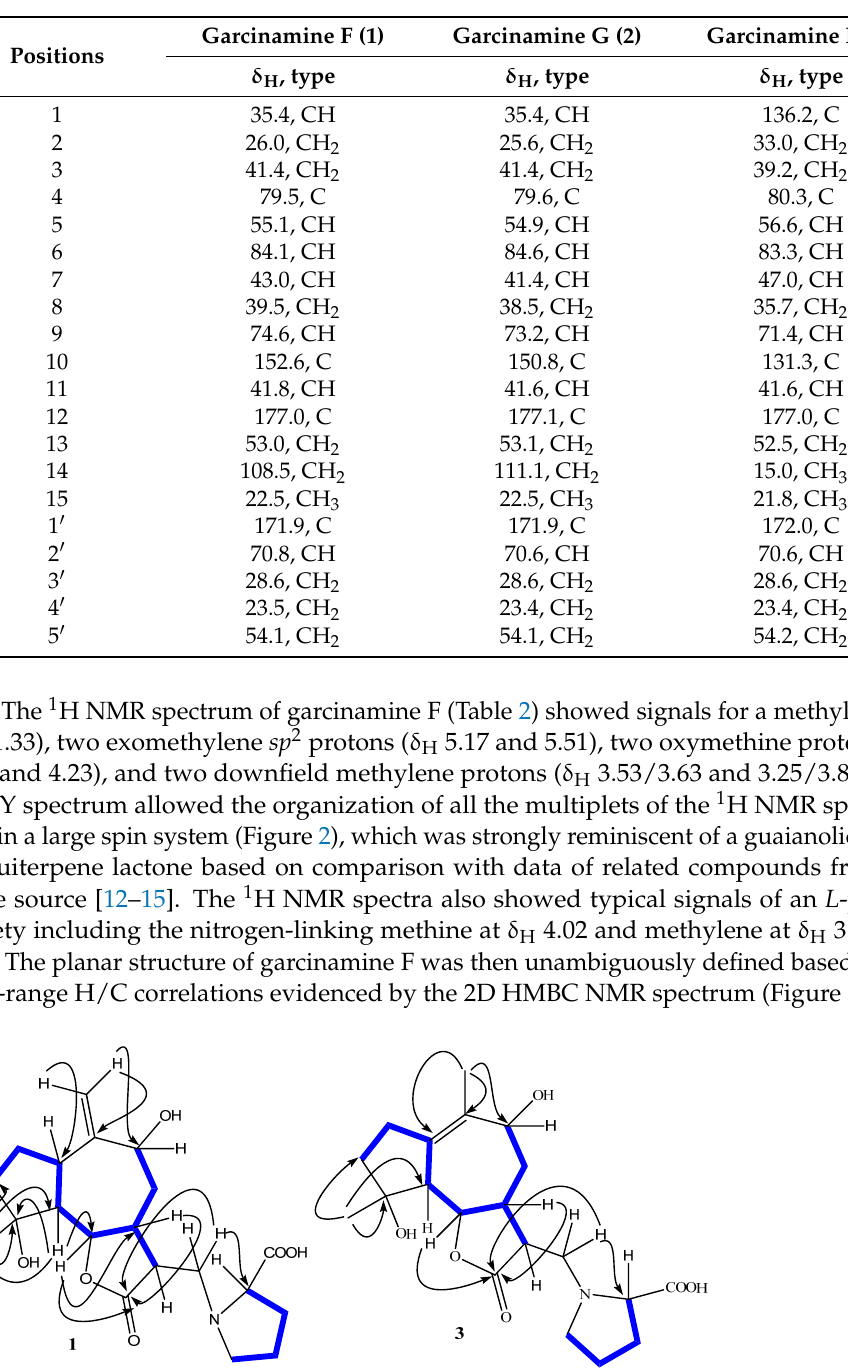
Table 1. 13 C (125 MHz) NMR data for garcinamines F–H ( 1 – 3 ) in CD 3 OD.